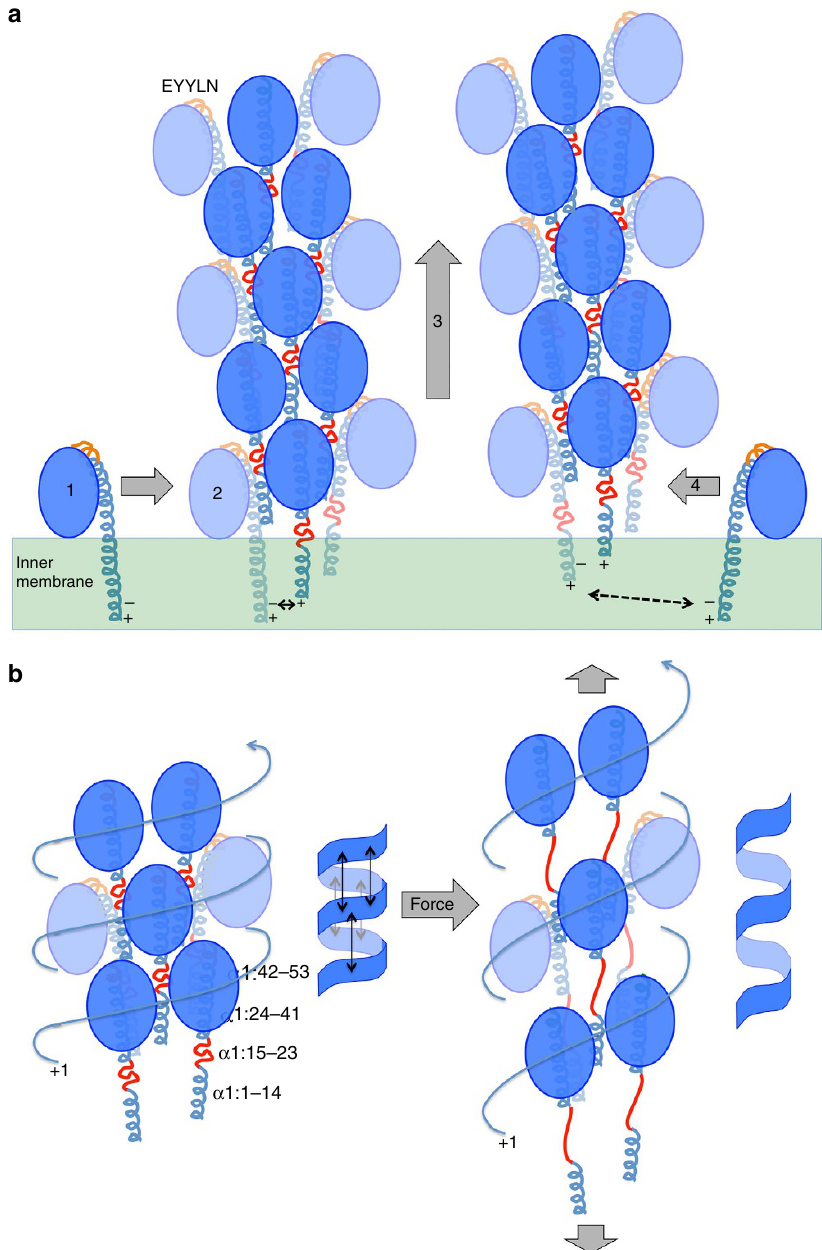
Figure 6 | Models for Type IV pilus assembly and force-induced conformational change. ( a ) T4P assembly model. (1) Before their incorporation into pilus filaments pilin subunits are anchored in the inner membrane with a 1 in an all-helical conformation to shield backbone oxygens and nitrogens from the acyl phase of the lipid bilayer. (2) Pilin subunits dock into a growing pilus filament, attracted in part by charge complementarity between Glu5, represented by the ( (cid:2) ) charge, and the positively charged N-terminal amine ( þ ) on the terminal subunit in the growing pilus. (3) The pilus filament is extruded out of the membrane a short distance by the pilus assembly machinery, opening up a gap at the base of the pilus for a new subunit to dock. As the newly added pilin is extruded out of the inner membrane a 1:15–23 (red) melts in order for a 1:1–14 to pack into the filament core in an a -helical conformation. (4) Another subunit docks into the gap at the base of the pilus. The EYYLN epitope at the top of a 1 is shown in orange. This epitope is exposed at the tip of the pilus and buried along its length. ( b ) Model for the force-induced conformational change of Nm and Ng T4P. Left panel: in its relaxed T4P conformation subunits are held together by lateral interactions between the globular domains along the þ 1-start helix and alternating a 1Ns ( a 1:1–14) from the next turn up, as well as by axial interactions among the globular domains in consecutive turns of the þ 1-start helix (represented by the double-headed arrows in the schematic of the coil). The central portion of a 1, a 1:15–23 (red), is non-helical but compact. The EYYLN epitope (orange) is only exposed at the tip of the pilus. Right panel: under stress, the axial interactions are disrupted and a 1:15–23 becomes fully extended but the lateral interactions between the globular domains and a 1:1–14 are maintained for the most part, allowing a spring-like extension of the pilus to expose the EYYLN epitope all along its responsible for the structural heterogeneity observed during processing of the cryoEM images, which precluded a higher resolution reconstruction.